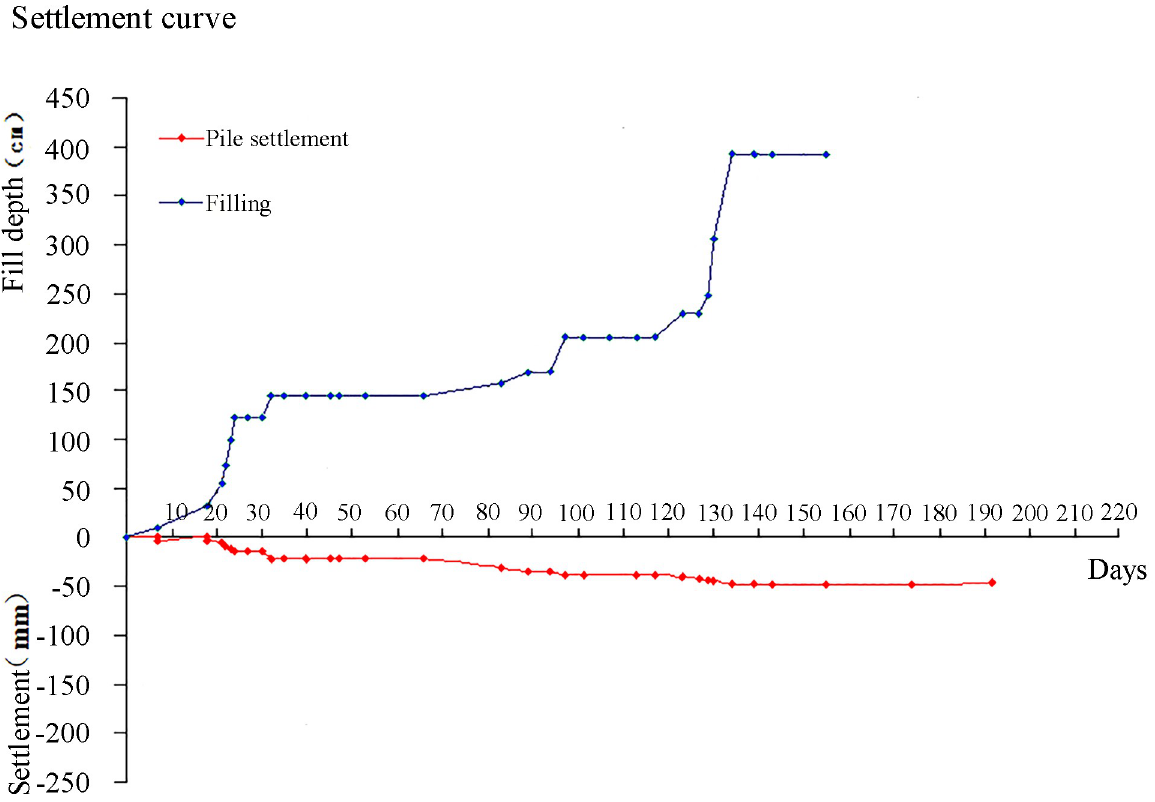
Fig 11. The time-dependent settlement of